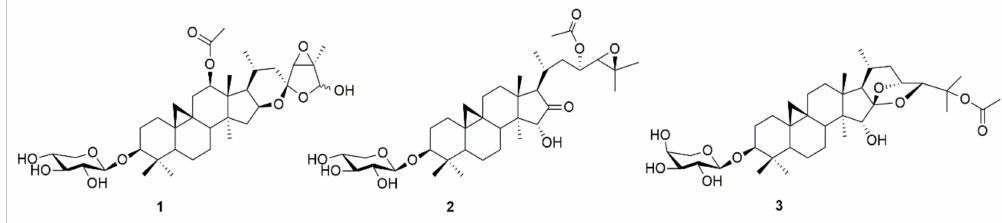
Figure 1. Chemical structures of actein ( 1 ), 23- O -acetylshengmanol-3- O - β - d -xylopyranoside ( 2 )